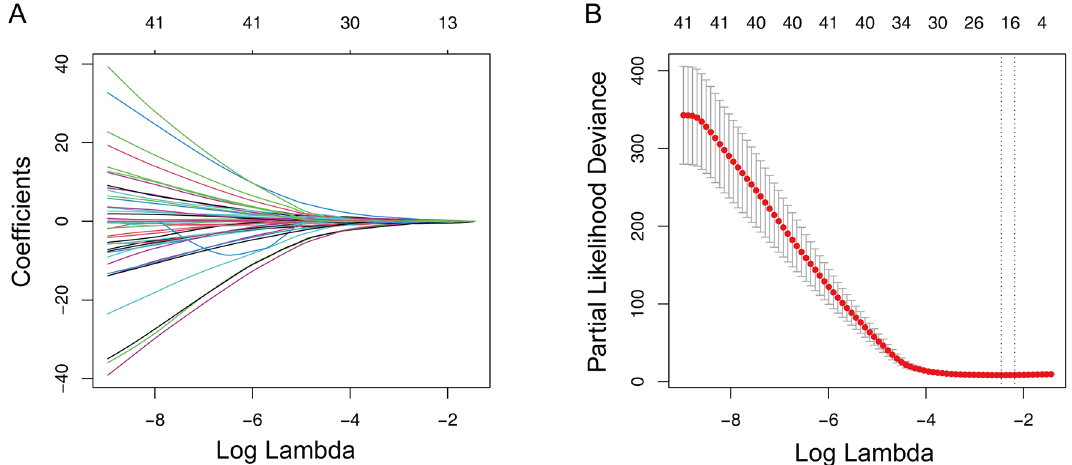
Figure 2. LASSO regression analysis for the construction of prognostic gene signature. ( A ) Cross-validation for tuning parameter screening upon LASSO regression analysis. ( B ) Screening of optimal parameter (lambda) at which the vertical lines were drawn. LASSO the least absolute shrinkage and selection operator Cox regression model.